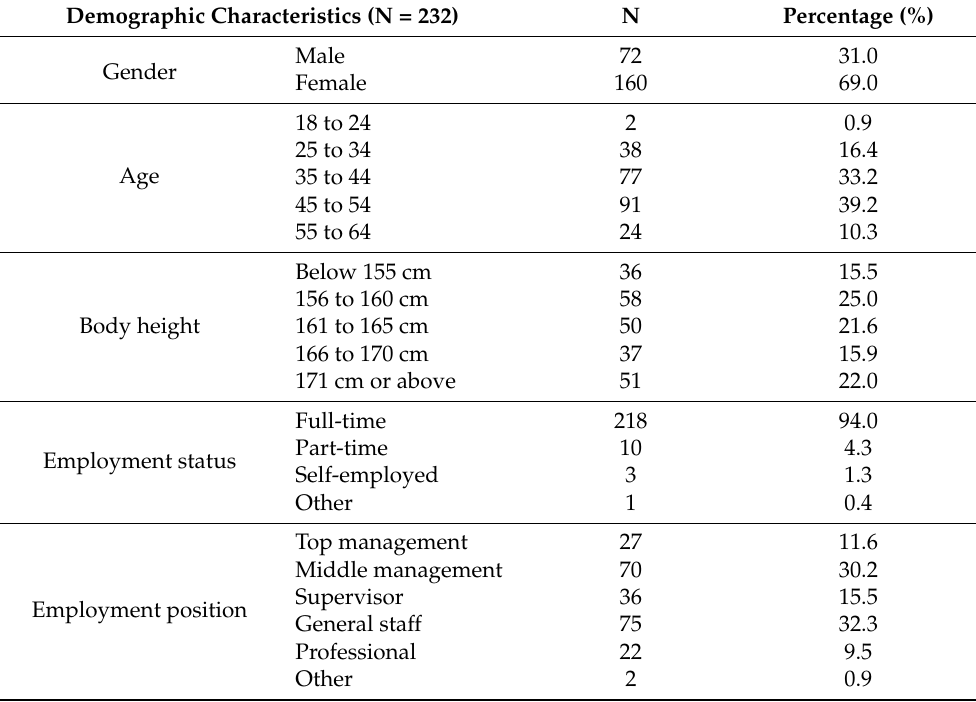
Table A1. Demographic characteristics of homeworkers.